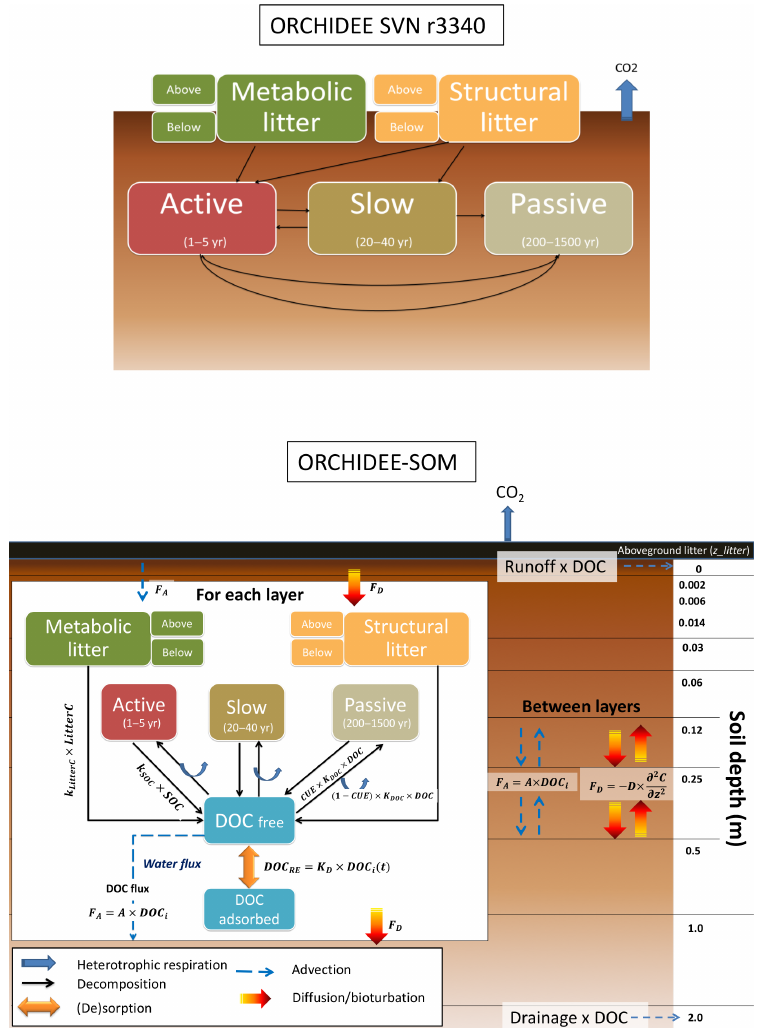
Figure 1. Overview of the revised version of ORCHIDEE-SOM presented here (lower panel) compared to the soil module in the trunk version of ORCHIDEE SVN r3340 (upper panel). The white box represents pools, fluxes, and major processes occurring in each of the 11 soil layers. The equations used for the processes occurring within and between layers are represented (see text for